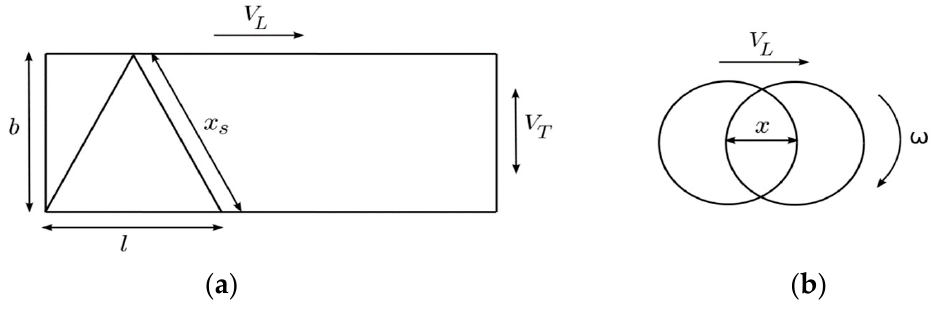
Figure 2. The two polishing conditions. ( a ) l ≤ d ; ( b ) x ≤ r .